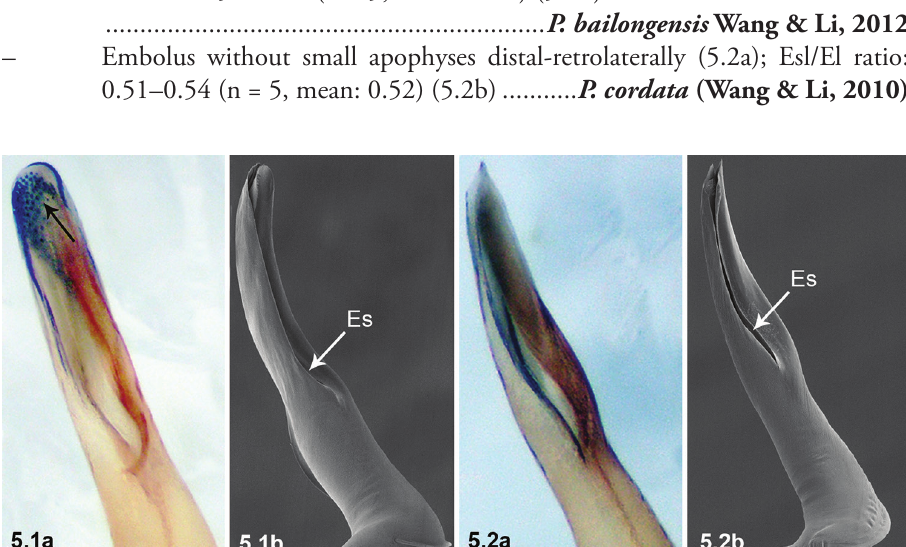
5 Embolus with small apophyses distal-retrolaterally (arrowed in 5.1a); Esl/ El ratio: 0.58–0.62 (n = 5, mean: 0.60) (5.1b) ........................................... ................................................................ P. bailongensis Wang & Li, 2012 – Embolus without small apophyses distal-retrolaterally (5.2a); Esl/El